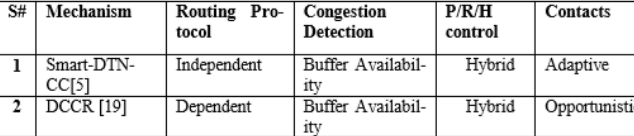
Table 2 and Table 3 a summary of current congestion control efforts is